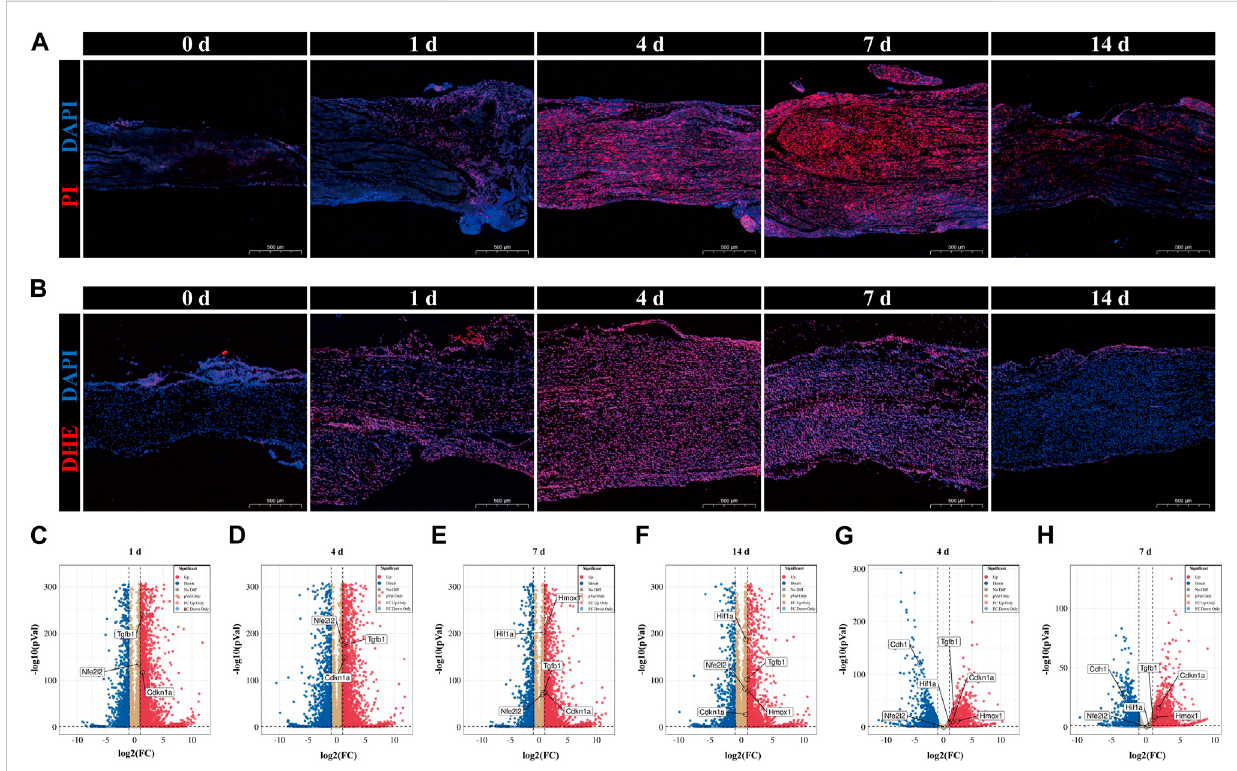
FIGURE 6 Validation of temporal alterations in ferroptosis and validation of datasets of hub genes. (A) Cell death in sciatic nerve was con fi rmed by PI and DAPI staining in the uninjured group (0 days) and 1-day group, 4-day group, 7-day group and 14-day group after nerve injury. PI in red and DAPI in blue. Scale bar = 500 μ m. (B) ROS accumulation in sciatic nerve was authenticated by DHE staining in the 0-day (uninjured), 1-day, 4-day, 7-day and 14-day groups. DHEinredandDAPIinblue.Scalebar=500 μ m. (C - F) VolcanoplotsofDEGsof1-daygroup,4-daygroup,7-daygroup,and14-daygroupinsciatic nerve after crush injury compared to 0-day group (uninjured, control). The information came from SRP113121. (G , H) Volcano plots of DEGs of 4-day group, and 7-day group in sciatic nerve after crush injury compared to 0-day group (uninjured, control). The information came from GSE162548. (C-H) Reddotsdenotesigni fi cantlyupregulatedgenesandbluedotsdenotesigni fi cantlydownregulatedgeneswithanadjusted p -value < 0.05and|log2FC| >